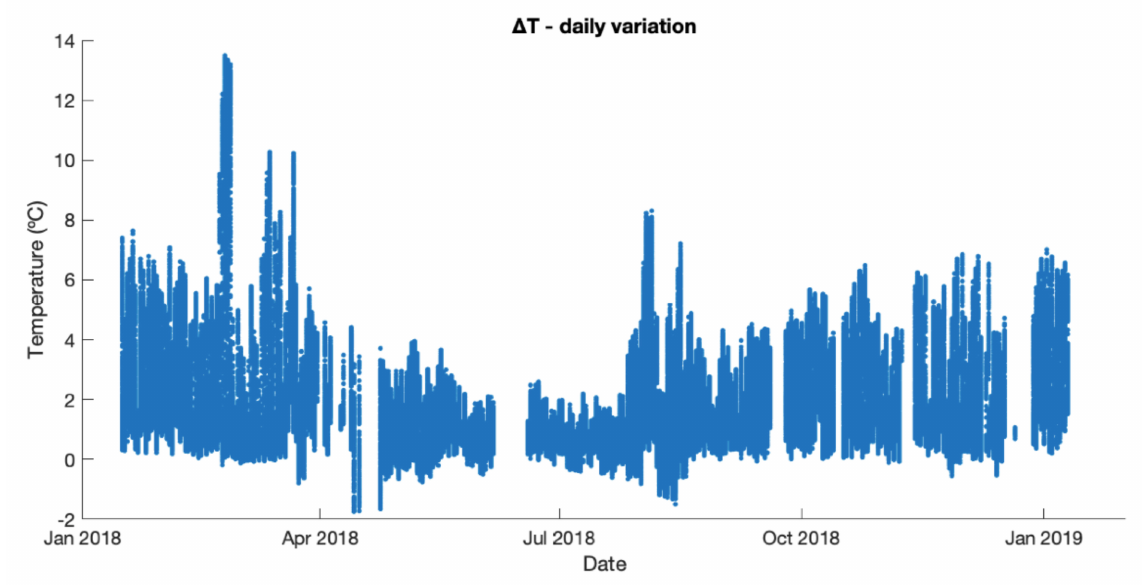
Figure 8. Yearly ∆ T